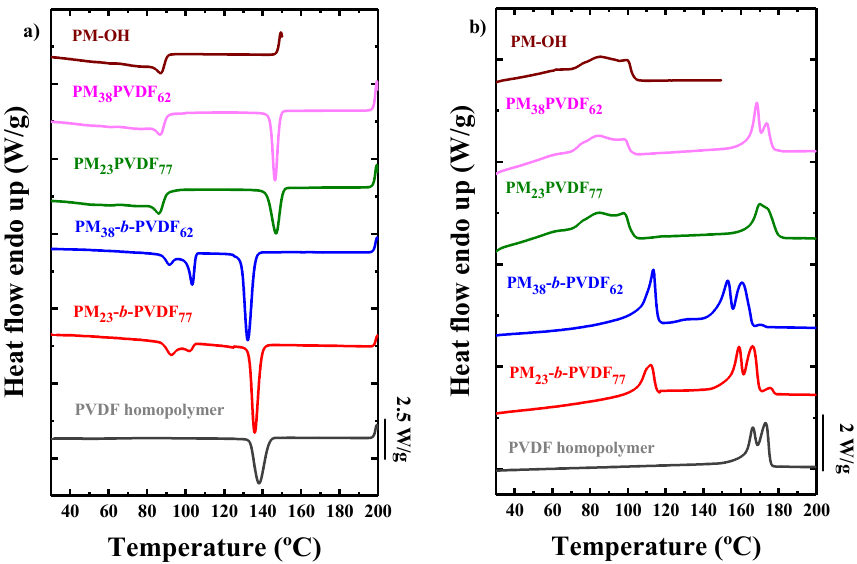
Figure 4. DSC scans of the blends, the diblock copolymers, and homopolymers samples. ( a ) Cooling curves at 20 °C/min and ( b ) heating curves at 20 °C/min after the previous cooling process.